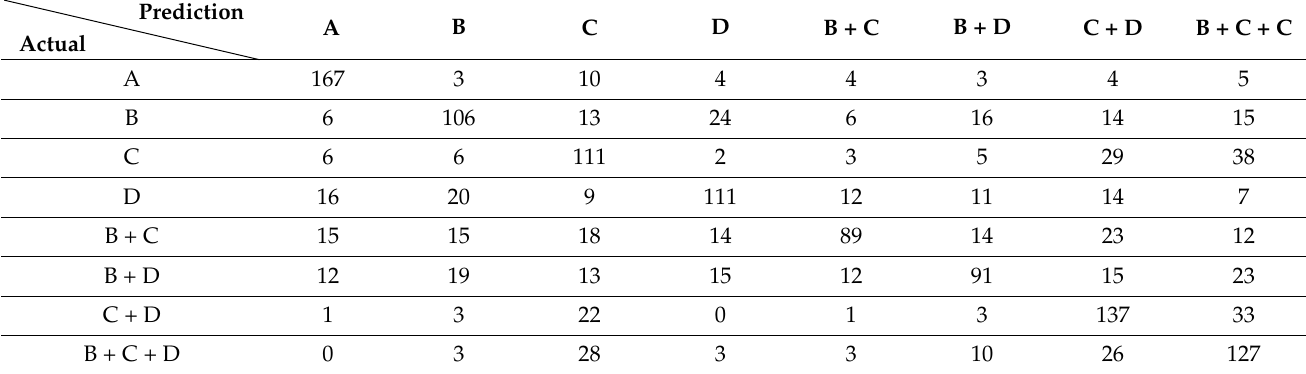
Table 12. Confusion matrix of the model based on time-domain